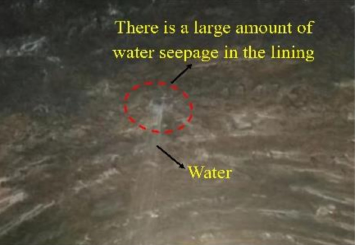
Figure 1. Seepage and leakage of tunnel lining.